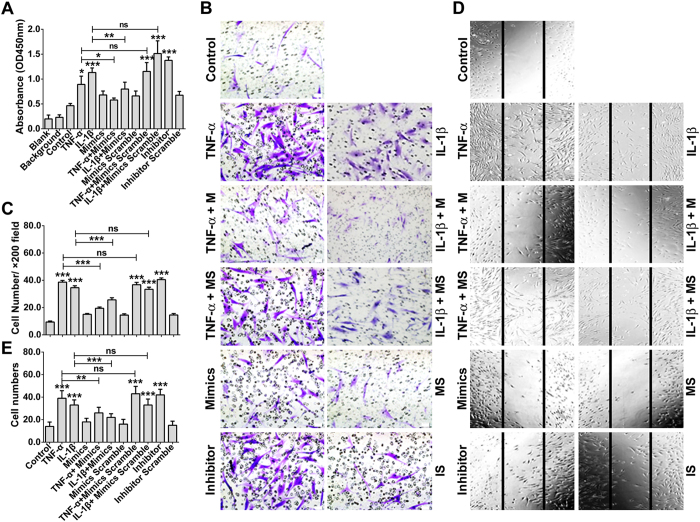
miR-10a mediates the regulation of RA FLS proliferation, migration and invasion by TNF-α and IL-1β.(A) RA FLS cells were transfected or treated as indicated, and BrdU was added to the cells, followed by incubation for 24 h. The incorporation of BrdU into newly synthesized cellular DNA was then detected with a POD-conjugated anti-BrdU antibody in a scanning spectrophotometer. Scramble miRNA was used as the negative control. (B) FLS cells were treated as indicated, and the cell scratch assay was performed to evaluate the migration ability of the cells. (C) Statistical analysis of (B). (D) FLS cells were transfected or treated as indicated, and a transwell assay was used to evaluate the effect of miR-10a on the invasion of the cells. (E) Statistical analysis of (D). nsP > 0.05, *P < 0.05, **P < 0.01, ***P < 0.001 compared with the control group or between the indicated groups. M: miR-10a mimics, MS: mimics scramble, IS: inhibitor scramble. The data are representative of three experiments.